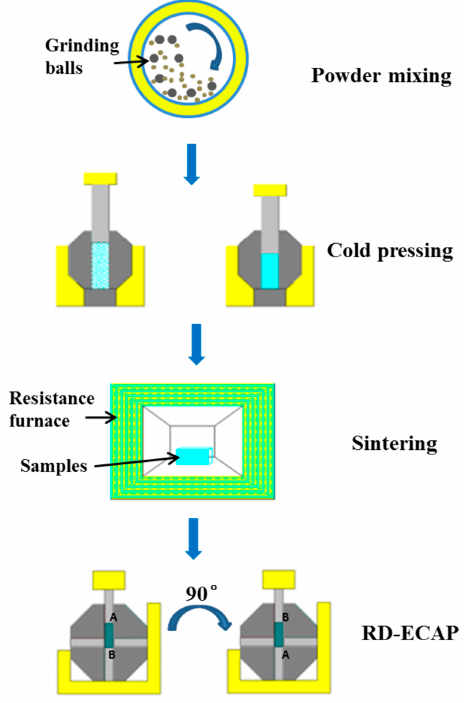
Figure 2. Schematic of the material